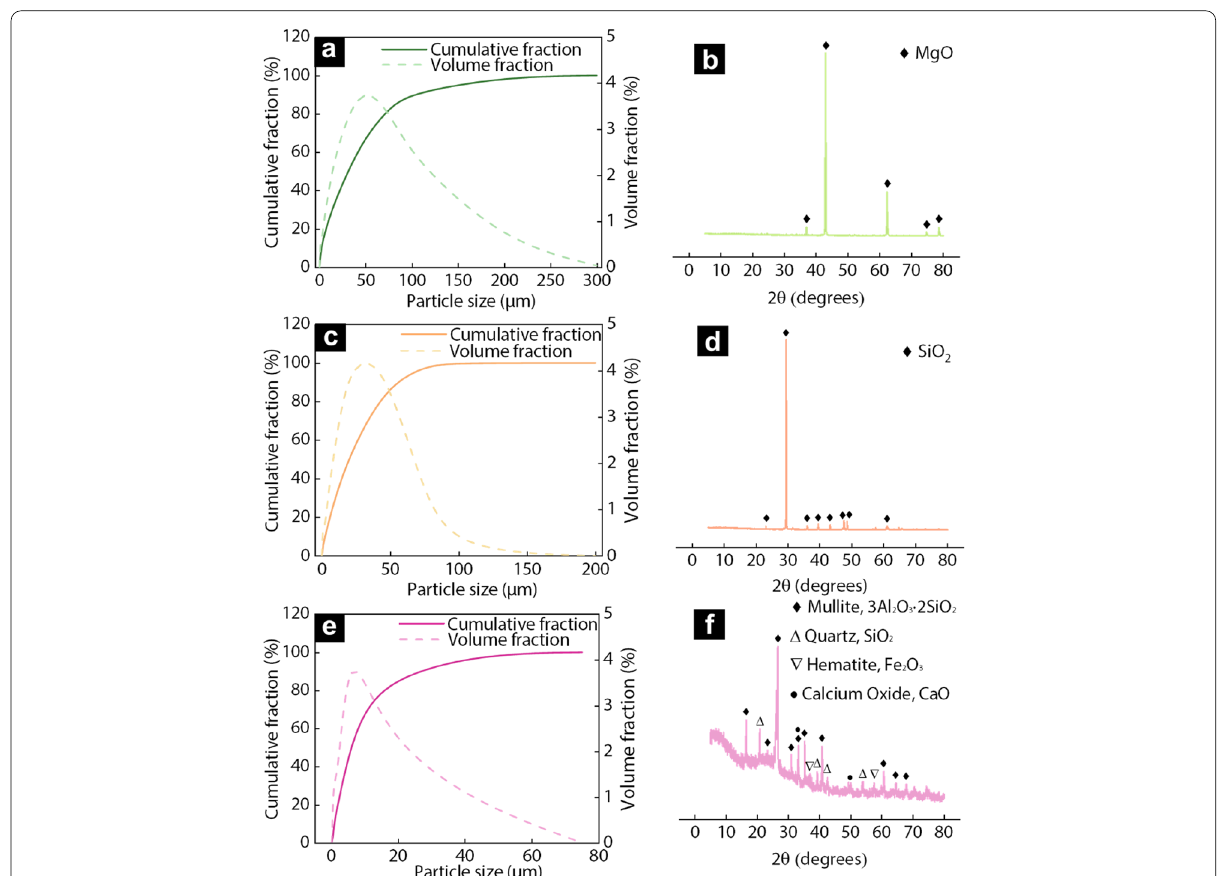
Fig. 2 Particle size distribution of a magnesium oxide, c quartz sand and e fly ash. Phase composition of b magnesium oxide, d quartz sand and f fly ash.